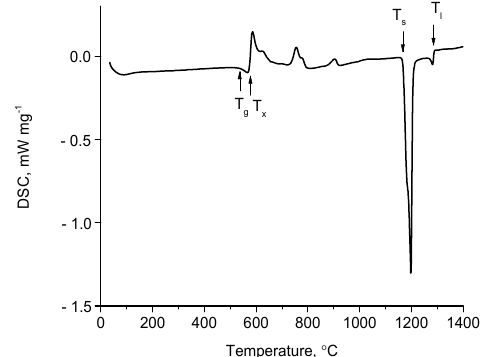
Figure 3. Differential scanning calorimetry (DSC) curve of the Fe 66 Cr 10 Nb 5 B 19 feedstock powder (45–75 µm).